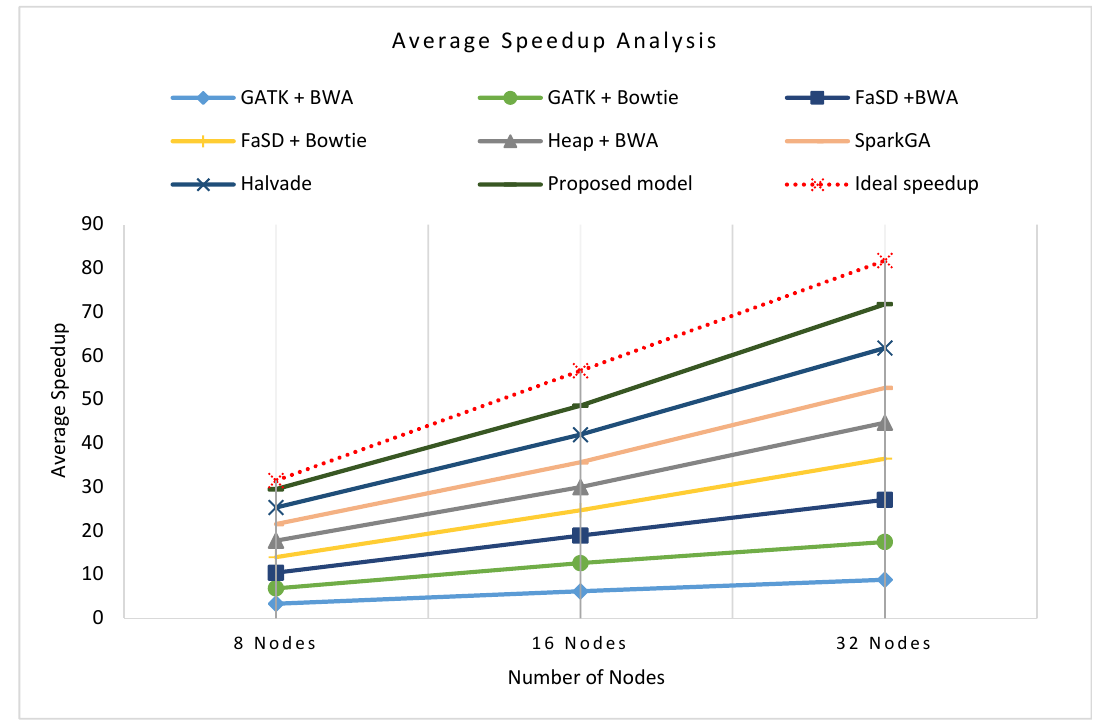
Figure 9. Average speed up analysis of the proposed workflow in comparison with existing workflows on a number of various nodes. The graphical representation shows that the proposed workflow achieved higher speedup performance on average of all clusters and datasets as compared to other frameworks.